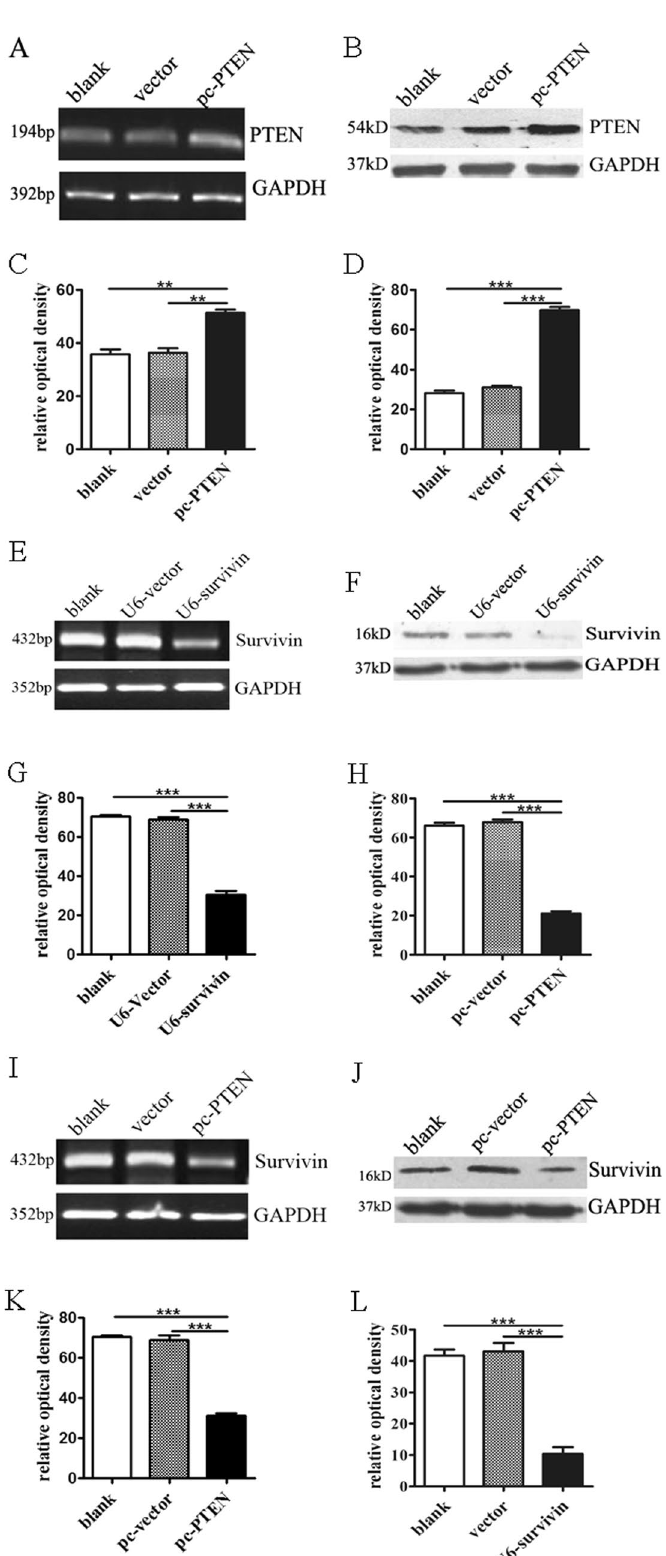
Figure 3. ( A and B ) The over-expression of PTEN in mRNA and protein. The group of blank and vector transfection were controls. ( E and F ) The knock-down of survivin by shRNA in RA-FLS mRNA and protein. ( I and J ) The down-regulation of survivin by PTEN in RA-FLS mRNA and protein. All the results were normalized to the housekeeping gene GAPDH. ( C , D , G , H , K and L ) The results of three times with statistical analysis. “ ** ” stands for P < 0.01. “ *** ” stands for P <